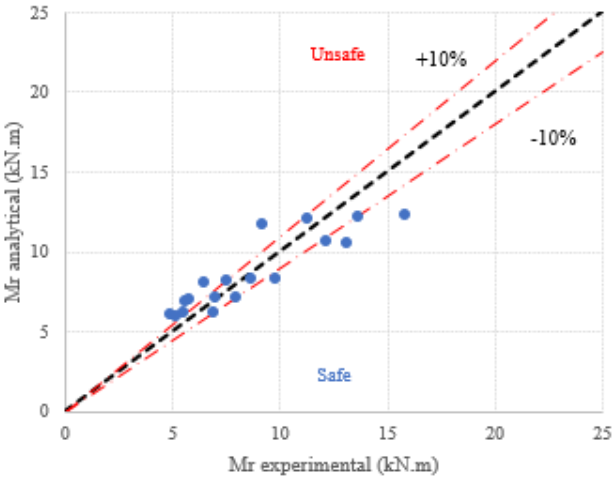
Figure 6. Post-fire moment capacity: analytical vs. experimental.